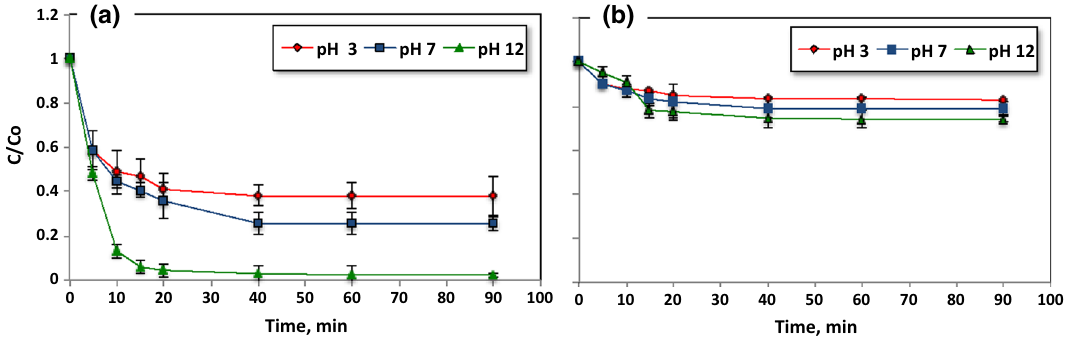
Fig. 6 Effect of pH on the MB photodegradation: a Co, dye = 5 ppm, b Co, dye = 50 ppm Table 2 Input and output statistics for statistical analysis system